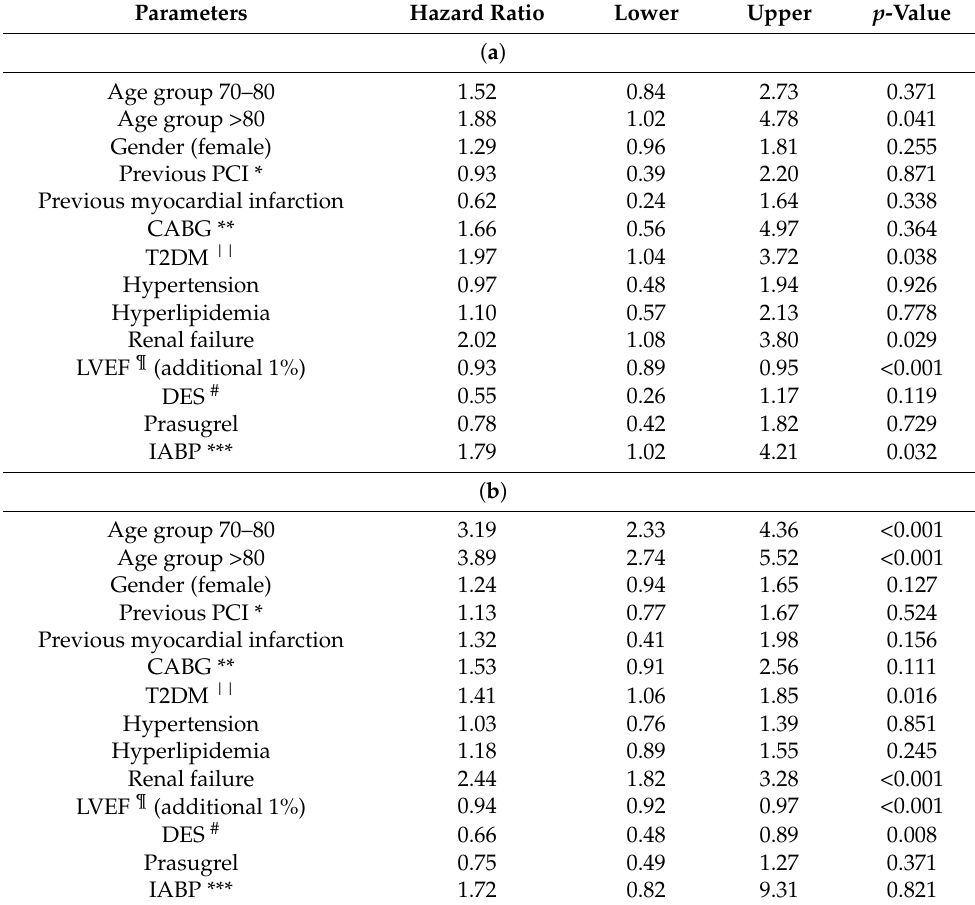
Table 4. ( a ) Cox regression analysis of 30-day mortality predictors. ( b ) Cox regression analysis of 3-year mortality